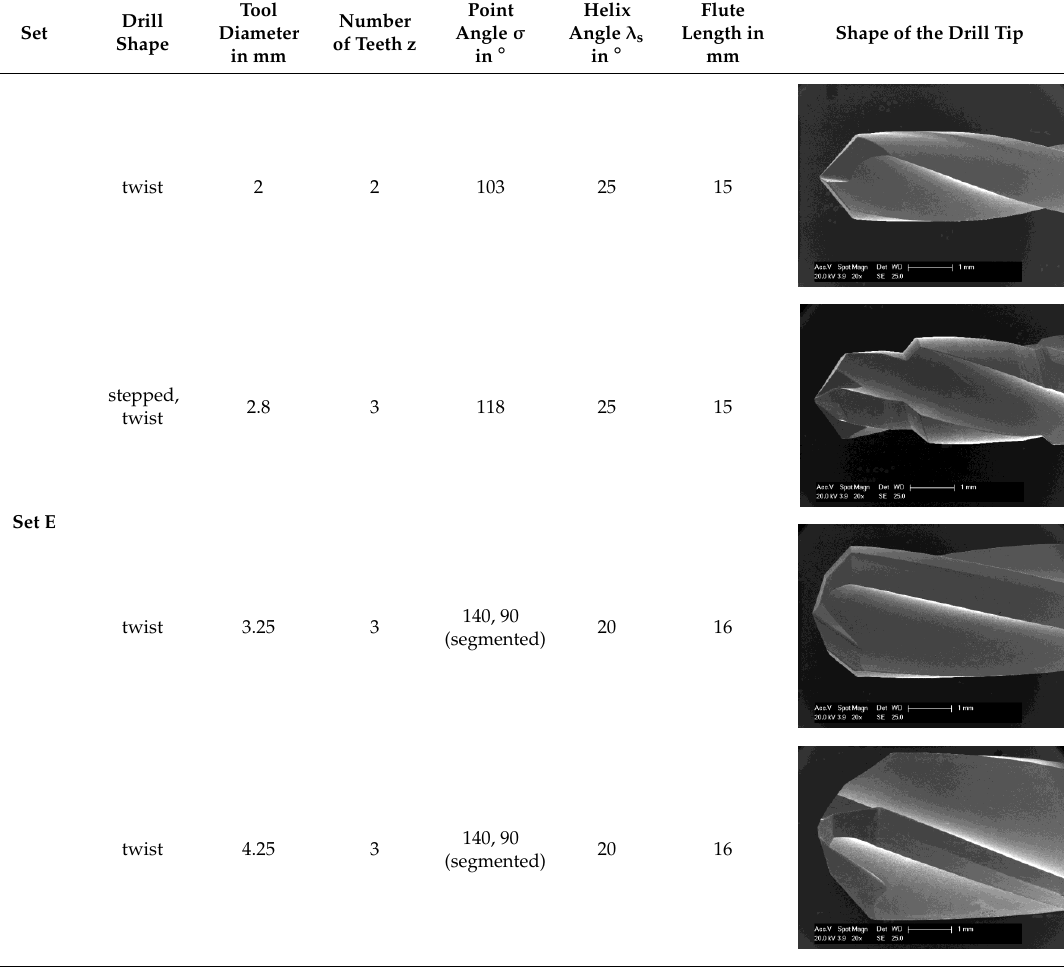
Figure 4. Exemplary signals of the thrust force F f of two subsequent drilling cycles for the same tool (Manufacturer B, Pilot